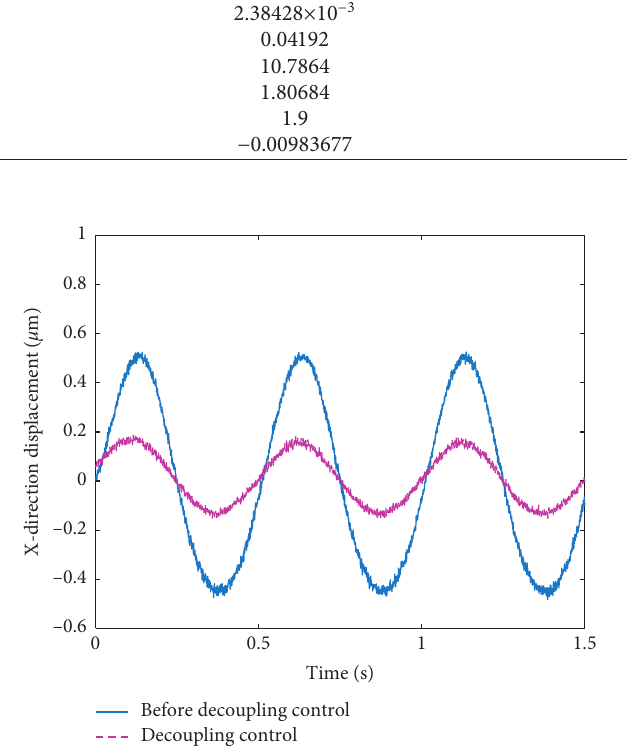
Figure 14: Decoupling control in the X -direction.